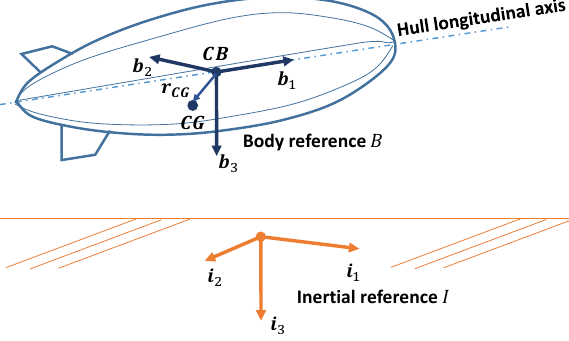
Figure 1. Inertial reference on ground, and body